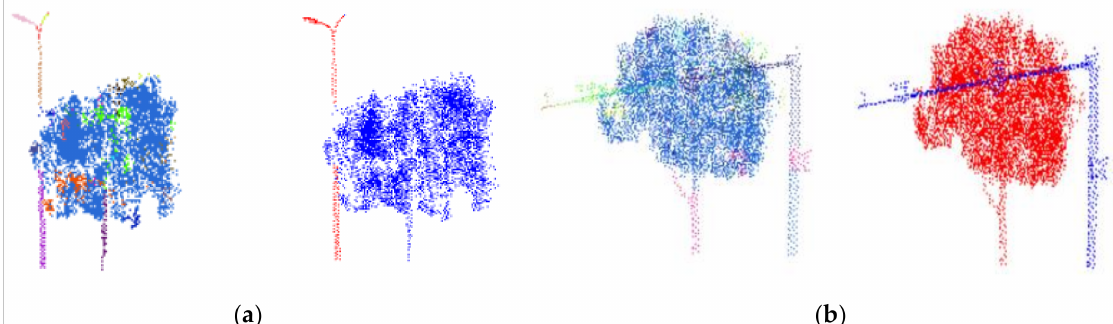
Figure 11. The above two pictures show the division of two different types of pole-like objects in the case of overlap. The ( a ) figure represents the segmentation process between tree and lamp, the ( b ) figure represents the segmentation process between tree and traffic